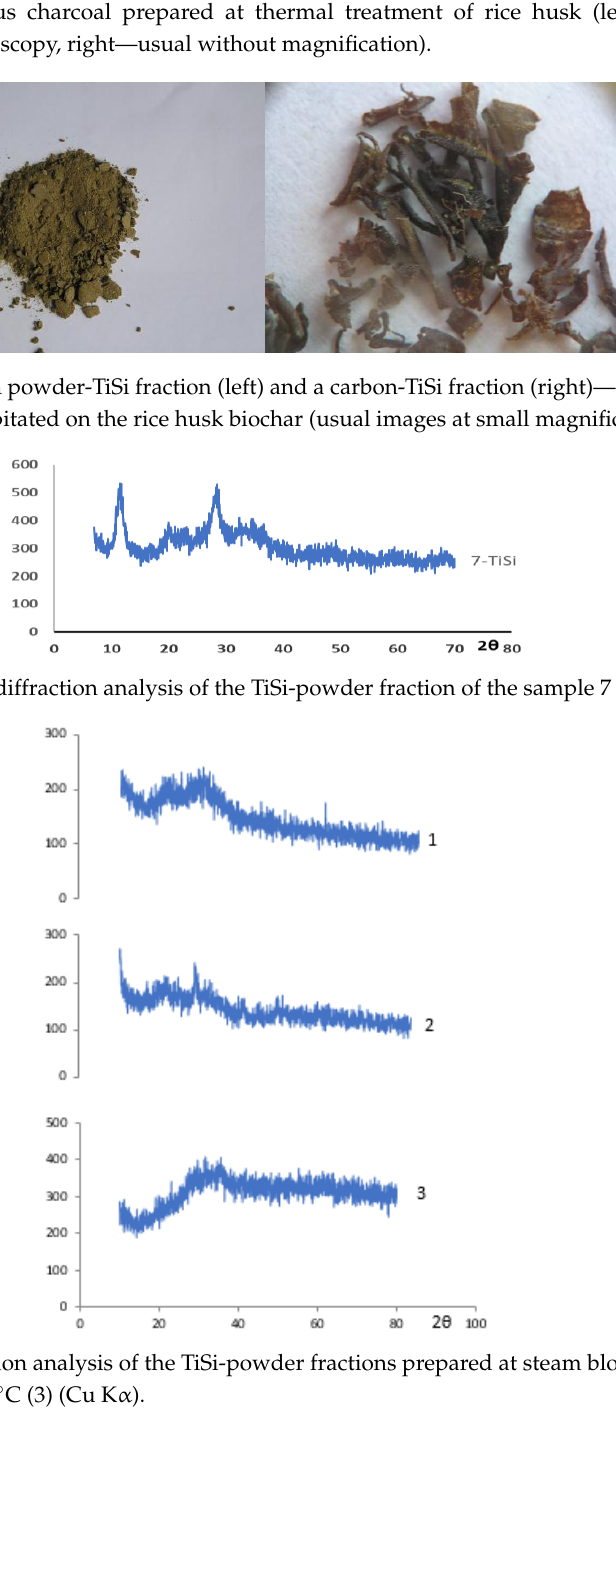
Figure 5. X-ray diffraction analysis of the TiSi-powder fractions prepared at steam blowing at 400 °С (1), 600 °С (2), and 800 °С (3) (Cu Kα).